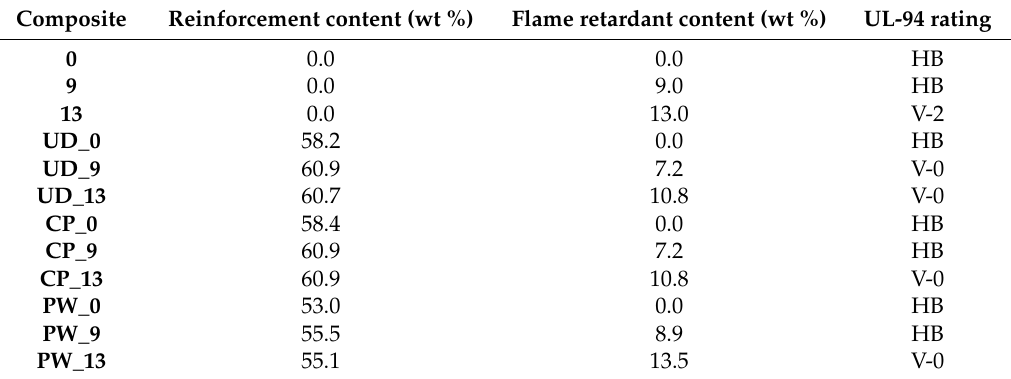
Table 2. UL-94 ratings of additive-free and flame retarded non-reinforced PP and PP SRCs.